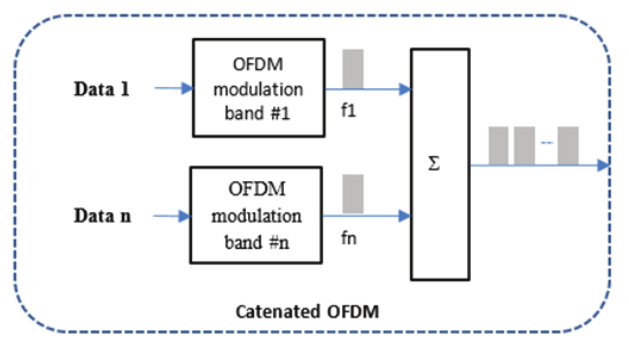
Fig. 1 Multiband catenated OFDM